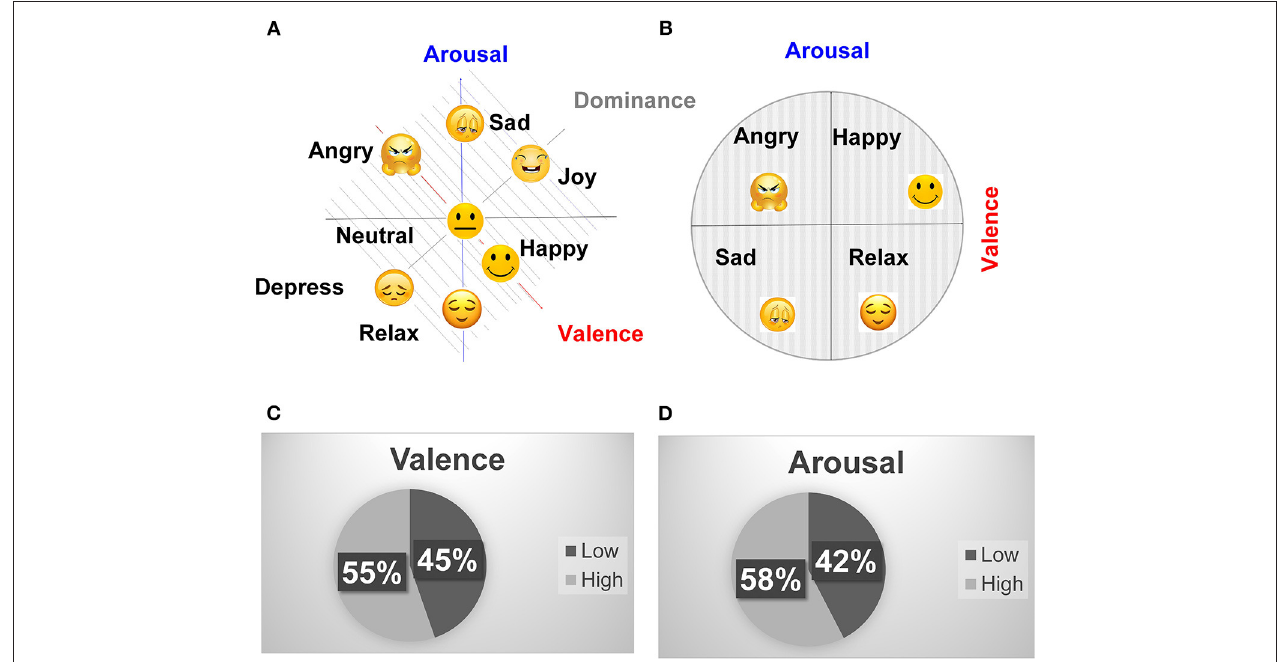
FIGURE 3 | (A) Mapping of different emotions on valence, arousal, dominance (3-D) and, (B) valence arousal (2-D) scale, (C) DEAP valence binary classification statistics, and (D) DEAP arousal binary classification